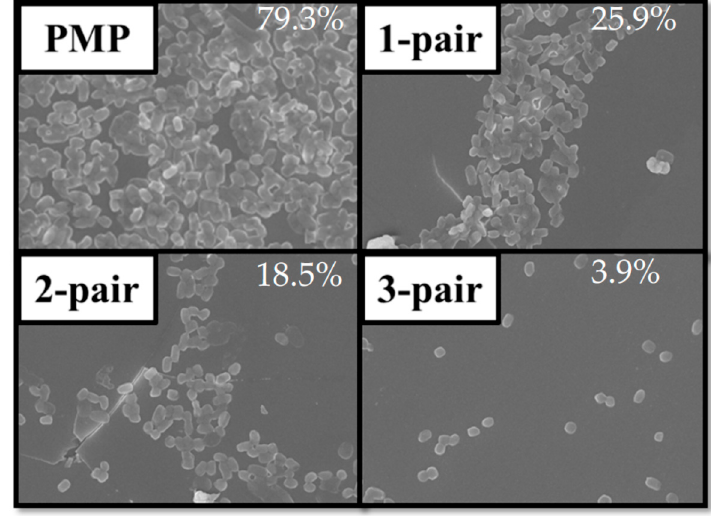
Figure 5. SEM images for Escherichia coli adhesion on PMP without and with different pairs of SiO x /SiC x H y stacked films at 72 h. The percentage represents the ratio of microbes to total area.